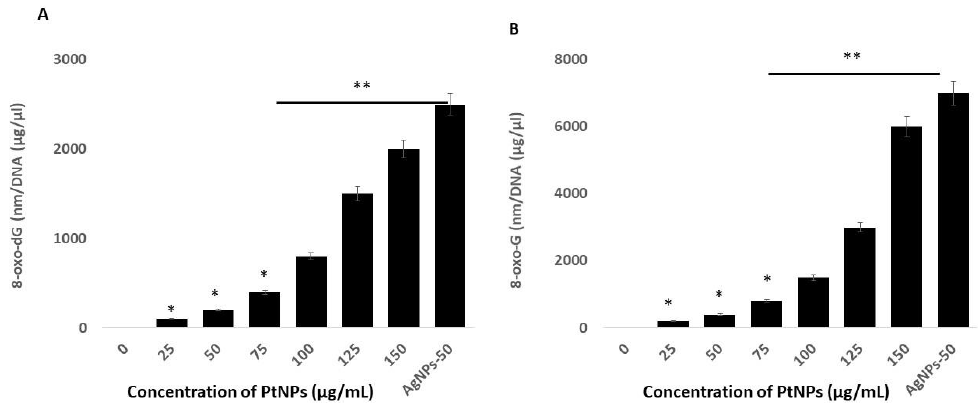
Figure 10. PtNPs increase oxidative damage to DNA and RNA. ( A ). THP-1 cells were treated with various concentrations of PtNPs (25–150 µ g / mL) for 24 h. The 8-oxo-2 (cid:48) -deoxyguanosine (8-oxo-dG) level was measured after 24 h of exposure. ( B ). THP-1 cells were treated with various concentrations of PtNPs (25–150 µ g / mL) for 24 h. The 8-oxoguanine (8-oxo-G) level was measured after 24 h of exposure. Results are expressed as means ± standard deviation from three independent experiments. There was a significant di ff erence between treated cells and untreated cells as per Student’s t -test (* p < 0.05). The treated groups showed statistically significant di ff erences from the control group by the Student’s t -test (* p < 0.05; ** p < 0.01). * significant; ** highly